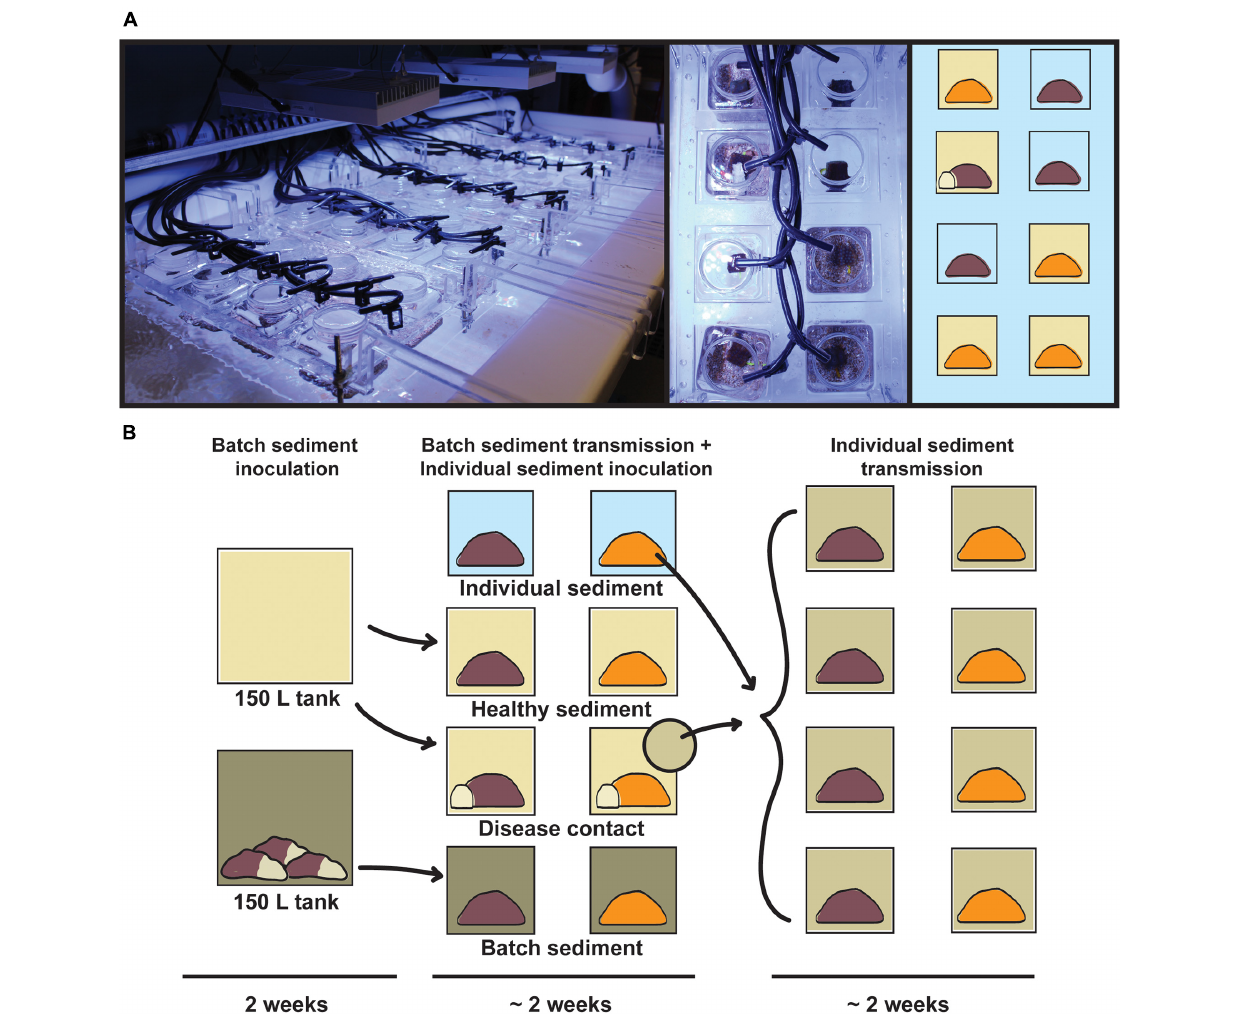
FIGURE 1 | Infographic of the transmission experiment apparatus and design. ( A , left) Acrylic rack system containing 40 0.5 L coral vessels in flow-through raceway, with individual seawater sources; (right) top-down view of randomized treatments for Orbicella faveolata (orange) and Montastraea cavernosa (brown). (B) Experimental design consisting of batch sediment inoculation (14 days), exposure of batch diseased sediments to experimental coral fragments ( ∼ 14 days), and exposure of individual diseased sediments to initial control fragments ( ∼ 14 days). Vessel background colors correspond to disease treatments: healthy sediment (beige), disease contact (beige with white coral fragment), batch diseased sediment (green), and individual diseased sediment (light